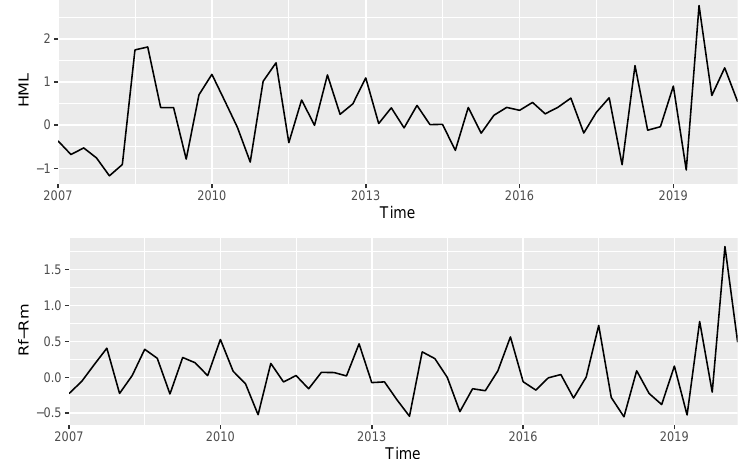
Figure A3. Asset Pricing/Macro Control Variables (1).